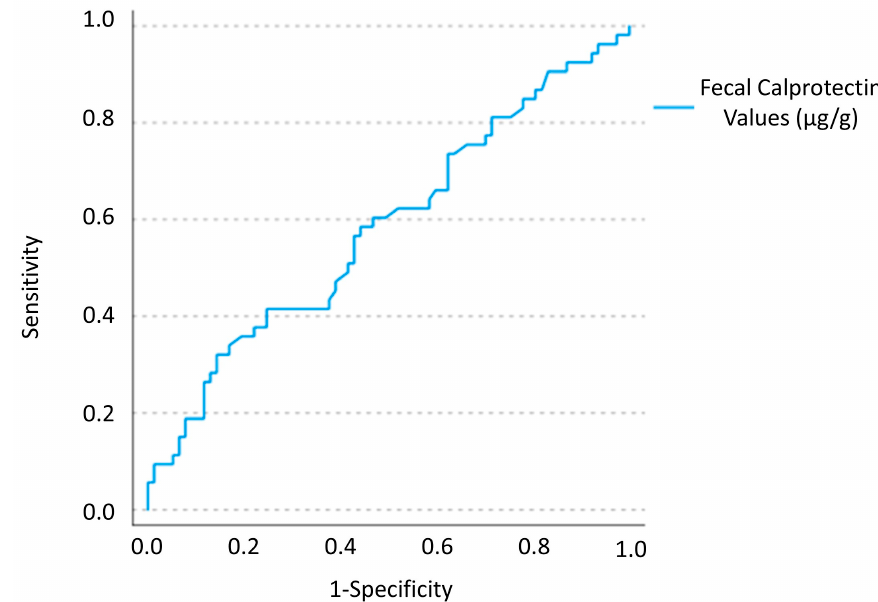
Figure 3. Receiver operating characteristic (ROC) curve analysis of the FCP values in the lactose tolerants vs . all intolerants.